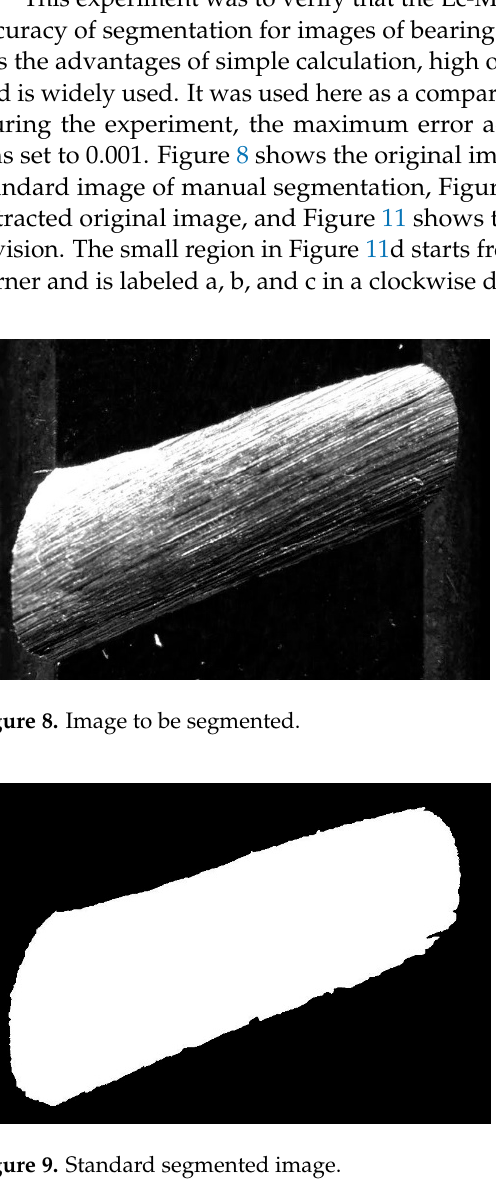
Figure 10. Multi-scale feature images.